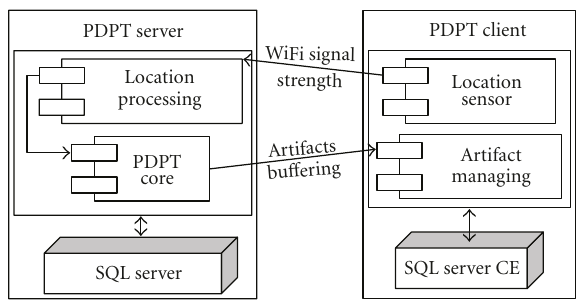
Figure 2: PDPT Framework architecture. Measured WiFi SS goes through the Location sensor to Location processing where the user position, current track, predicted track, and predicted user position are computed. PDPT Core makes a selection of artefacts to be prebu ff ered to mobile SQL Server